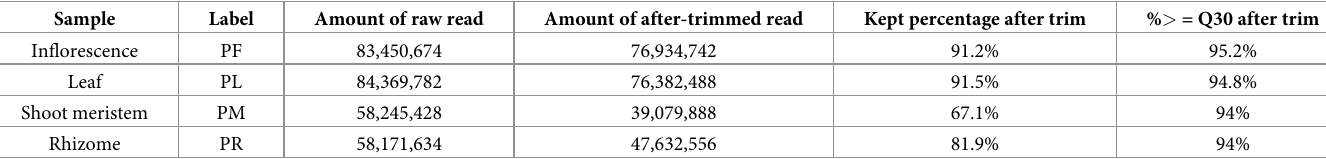
Table 1. Statistics of raw and trimmed reads from P . australis four tissues RNA-Seq data.